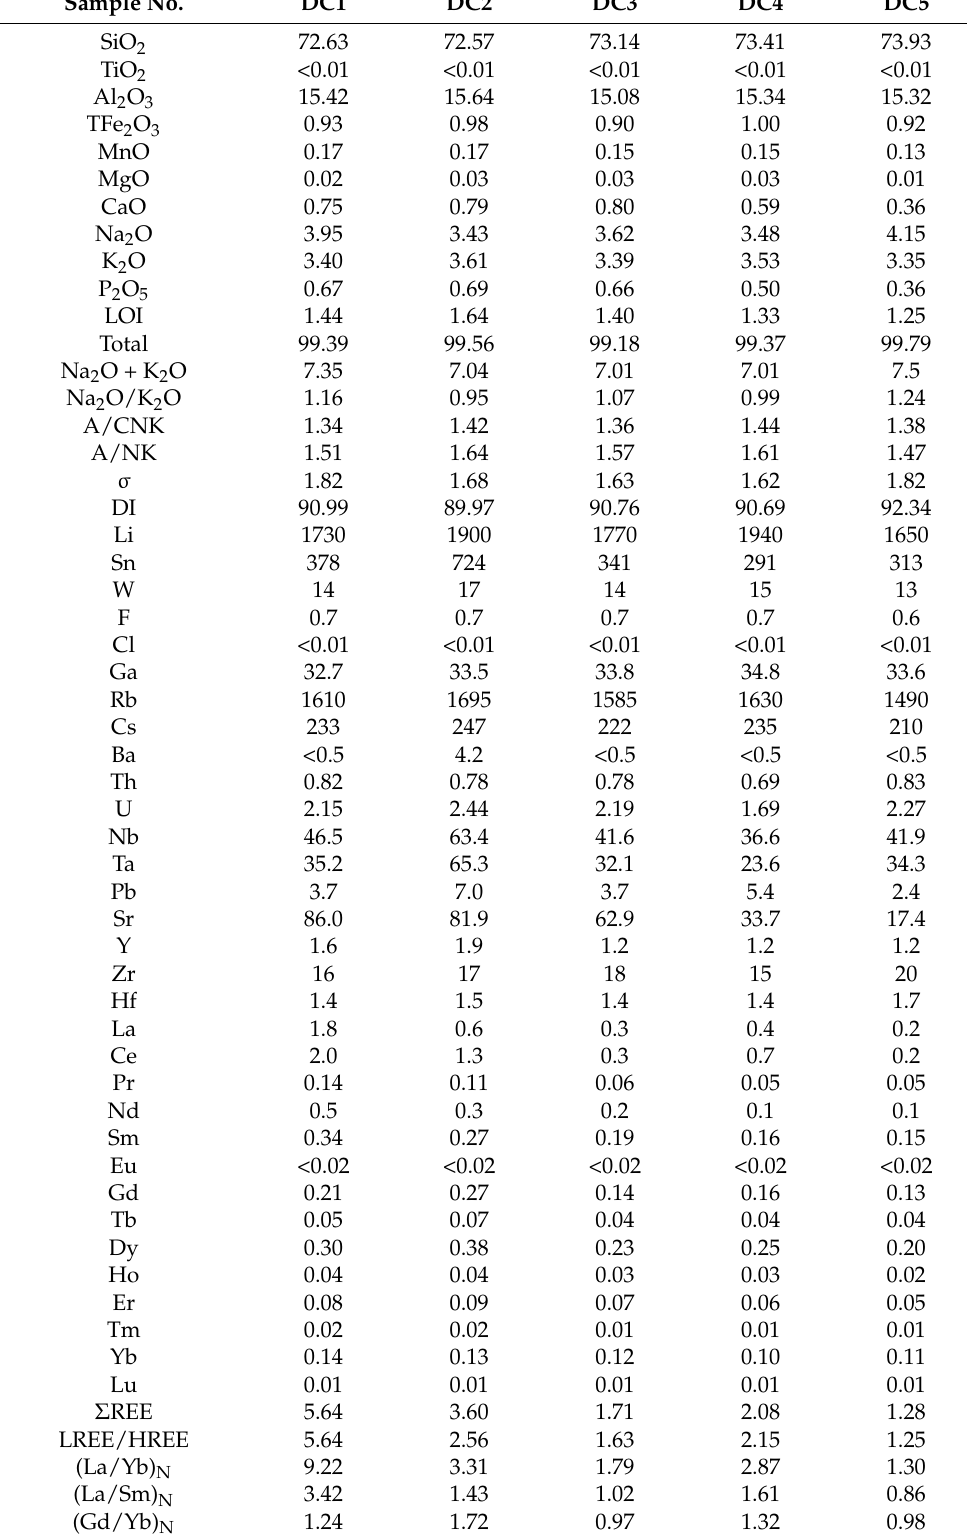
Table 2. Major element ( wt. %), trace element (mg/kg), and rare earth element (mg/kg) concentrations of Dongcao muscovite